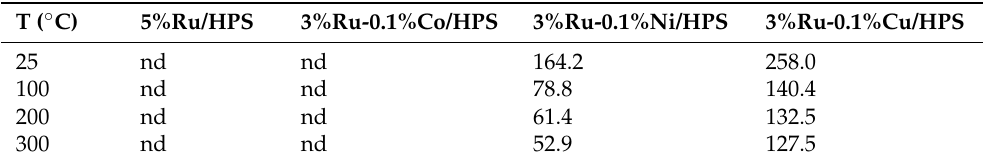
Table 1. Lewis acid sites (LAS) at different temperatures obtained from the infrared spectra using pyridine adsorbed on catalysts.